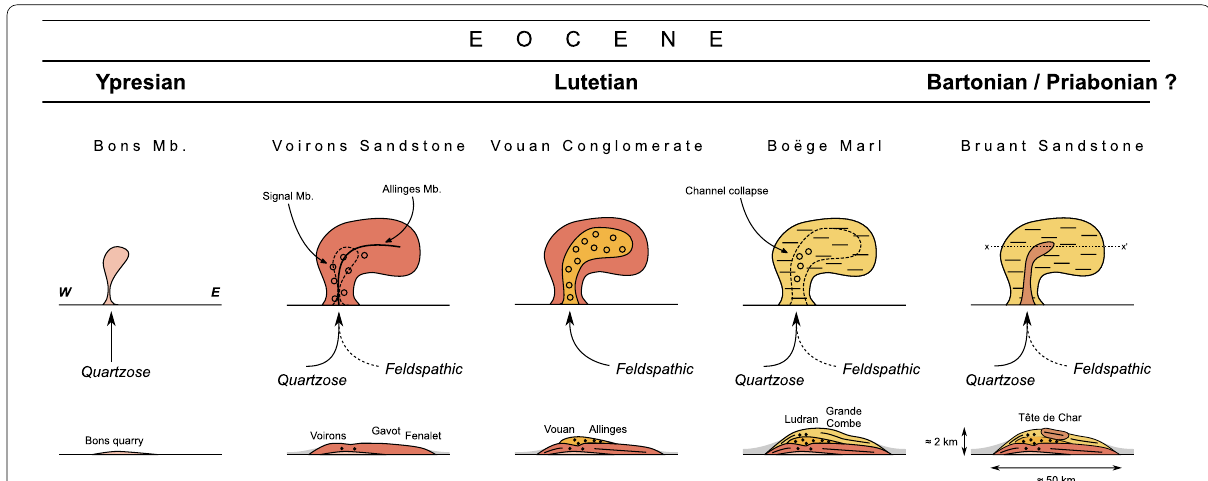
Fig. 14 Evolution of the Voirons Flysch deep‑sea fan during the Eocene with the major stratigraphic units in maps and cross sections, and their respective detrital sources. Cross‑sections are intentionally very exaggerated vertically. Please refer to the cross‑section depicted in Fig. 9 for a more detailed description and the main location of the stratigraphic